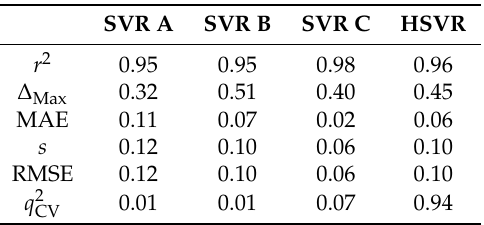
Table 2. Statistic evaluations, namely correlation coefficient ( r 2 ), maximum residual ( ∆ Max ), mean absolute error (MAE), standard deviation ( s ), RMSE, and 10-fold cross-validation correlation coefficient ( q 2 ) evaluated by SVR A, SVR B, SVR C, and HSVR in the training set. CV